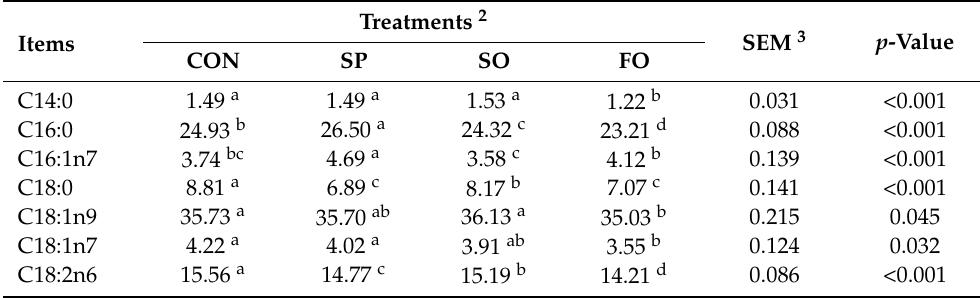
Table 7. Effects of dietary microalgae, salmon oil, and flaxseed oil on fatty acids contents (% of total fatty acids) of thigh meat in broiler chickens 1